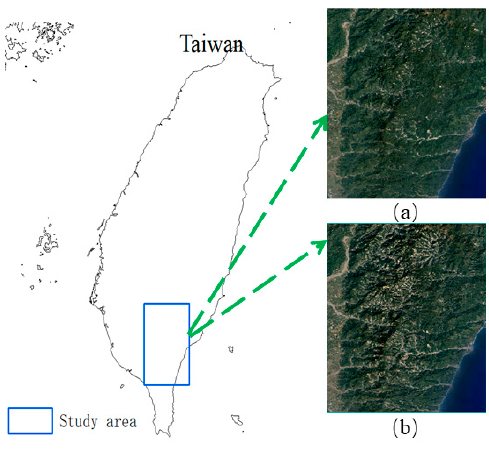
Figure 8. Study area demonstration: ( a ) image captured on 31 December 2008; ( b ) image captured on 31 December 2009.